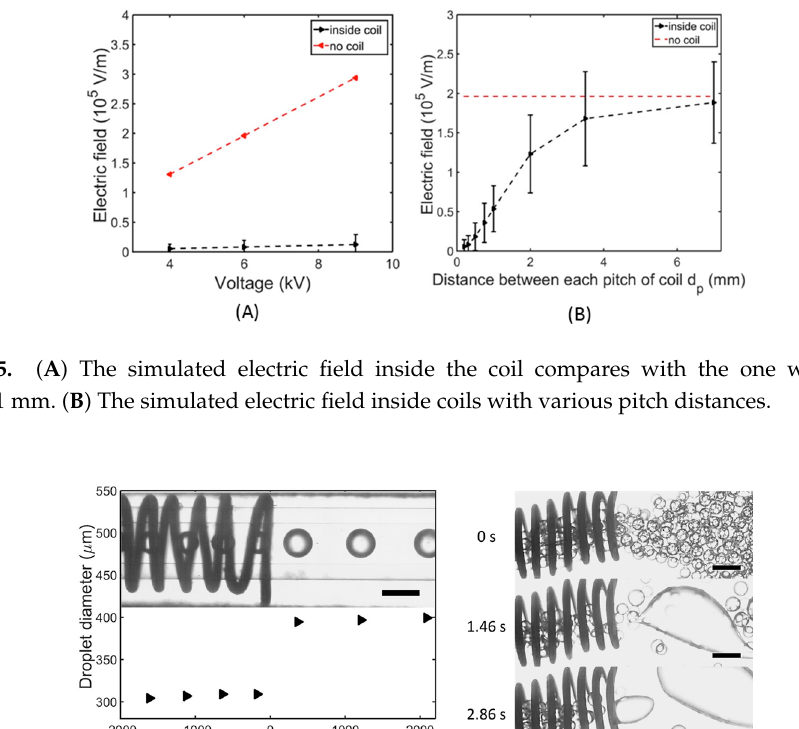
Figure 6. Dynamic behaviors of droplets in the device installed with a metallic coil when a voltage of ( A ) 7.9 kV is applied to a train of neighboring droplets; ( B ) 3 kV is applied to a dense population of emulsion droplets after 0 s. ( A ) A plot of the droplet diameter as a function of the distance from the outlet of the metallic coil. Inset: An optical microscope image of droplets as they exit the section of micro-channel surrounded by the coil. ( B ) A series of optical microscope images indicating the electro-coalescence of the droplets as they exit the metallic coil. Scale bars are 500 μ m.